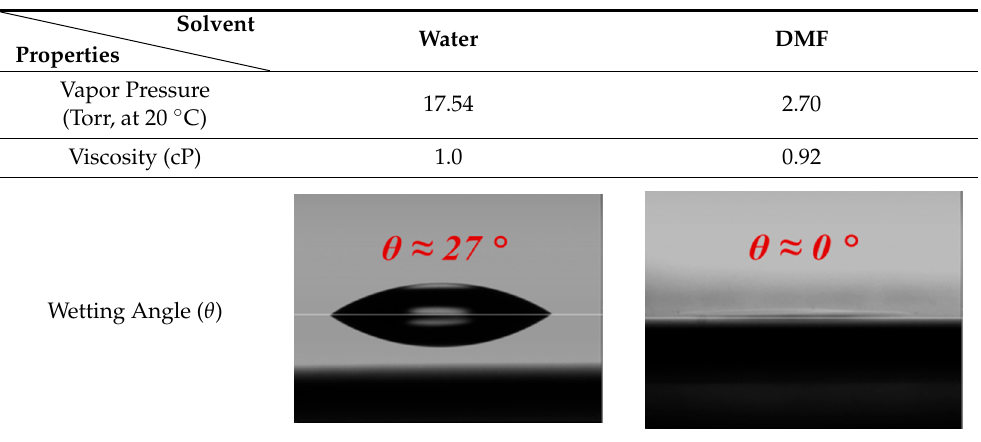
Table 1. Comparison of solvent properties between water and N,N -dimethyl-formamide (DMF).